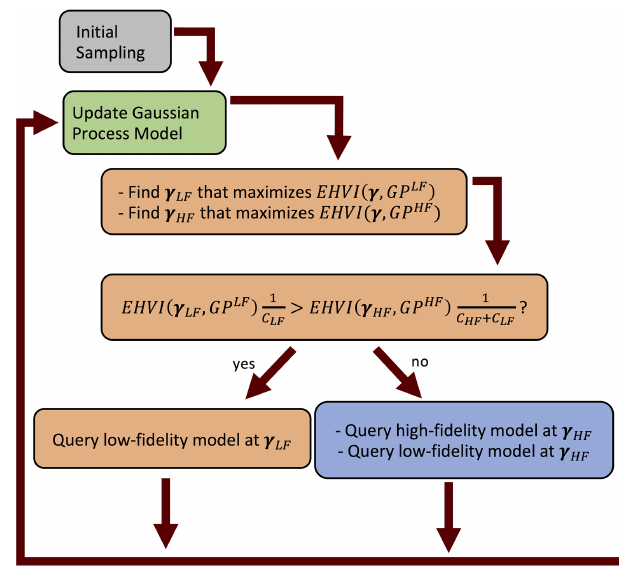
Figure 1. Workflow visualization for the bifidelity optimization case. h 1 is represented by GP LF , h 2 is represented by GP HF , C 1 is represented by C LF , and C 2 is represented by C HF